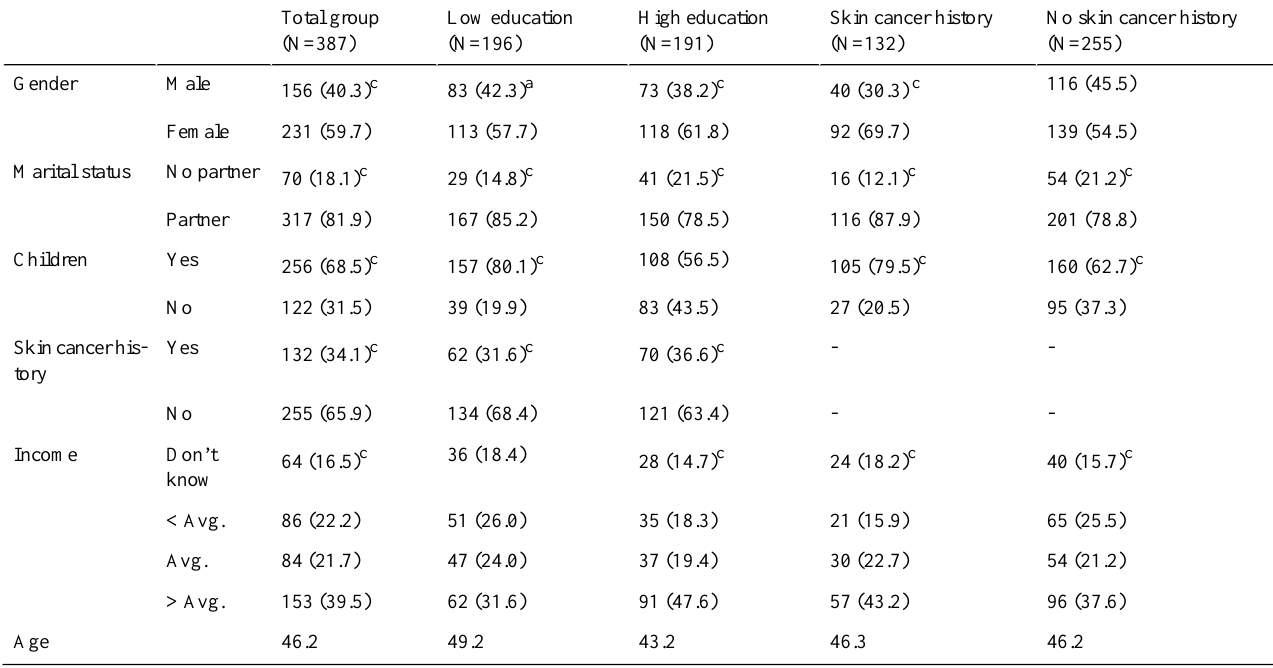
Table 2. Demographic characteristics of the overall sample, skin cancer patients, general population, and education